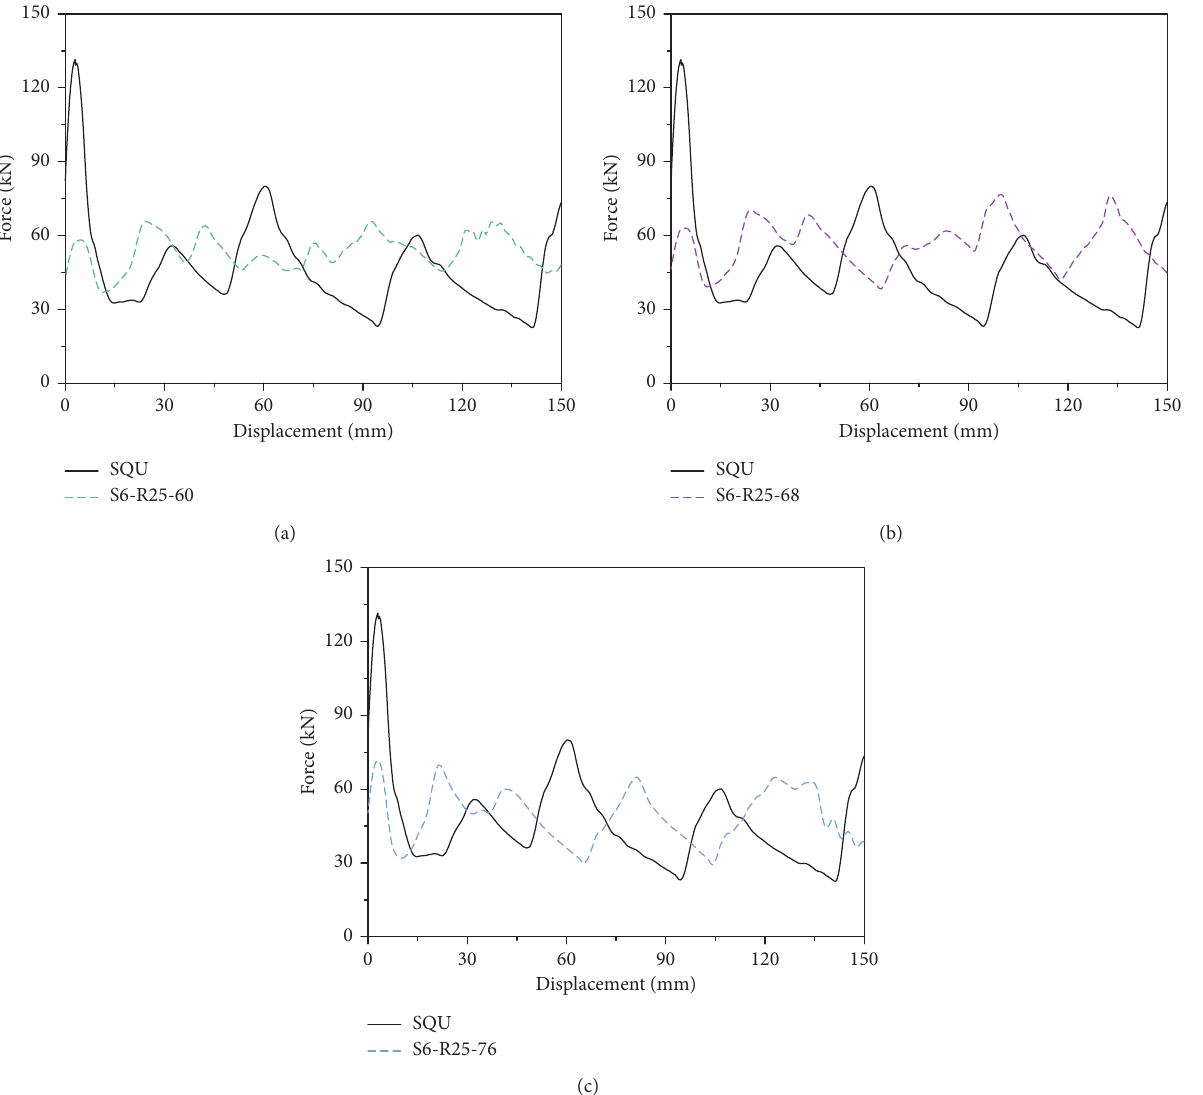
Figure 6: Comparison of force-displacement curves of SQU with (a) S6_R25_60, (b) S6_R25_68, and (c)